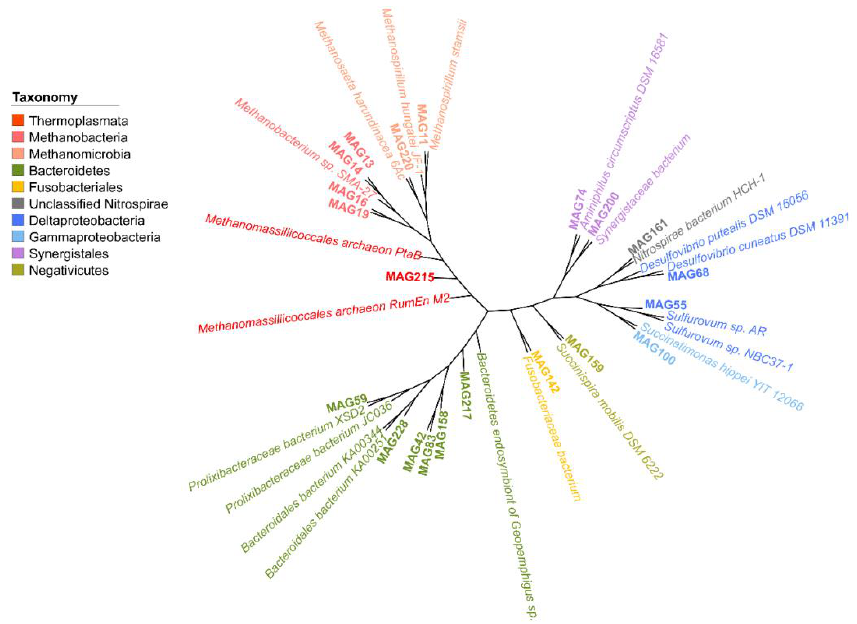
Figure 3. Taxonomic assignment of the curated MAGs reconstructed from the PSD and AnMBR metagenomes. The lineages of the MAGs and selected related organisms are shown in different colors.